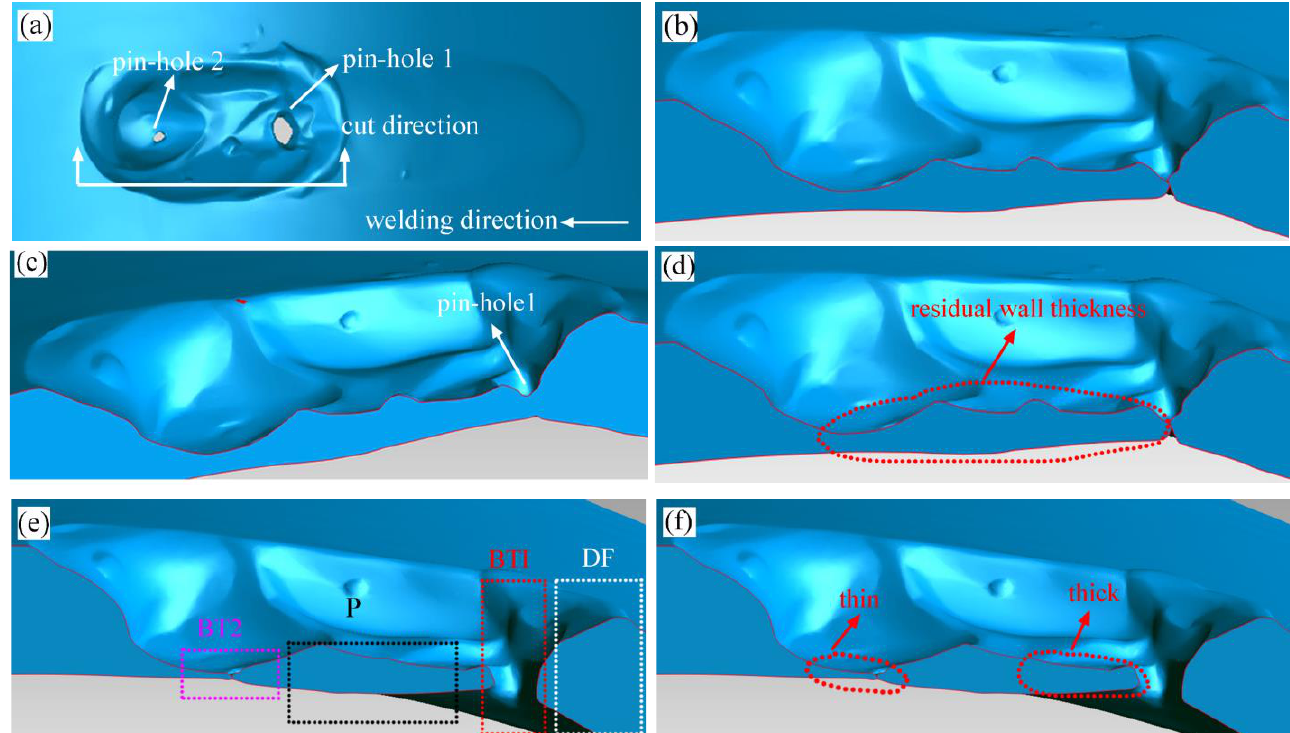
22 of 34 Figure 13. Method of cutting samples: ( a ) cut along the longitudinal path; ( b ) cut along the trans- verse path; ( c ) cut along the tangential path. The 24E-1 sample was used as a typical sample to analyze the evolution behavior of burn-through instability—cut the sample along the longitudinal direction near pinhole 1,